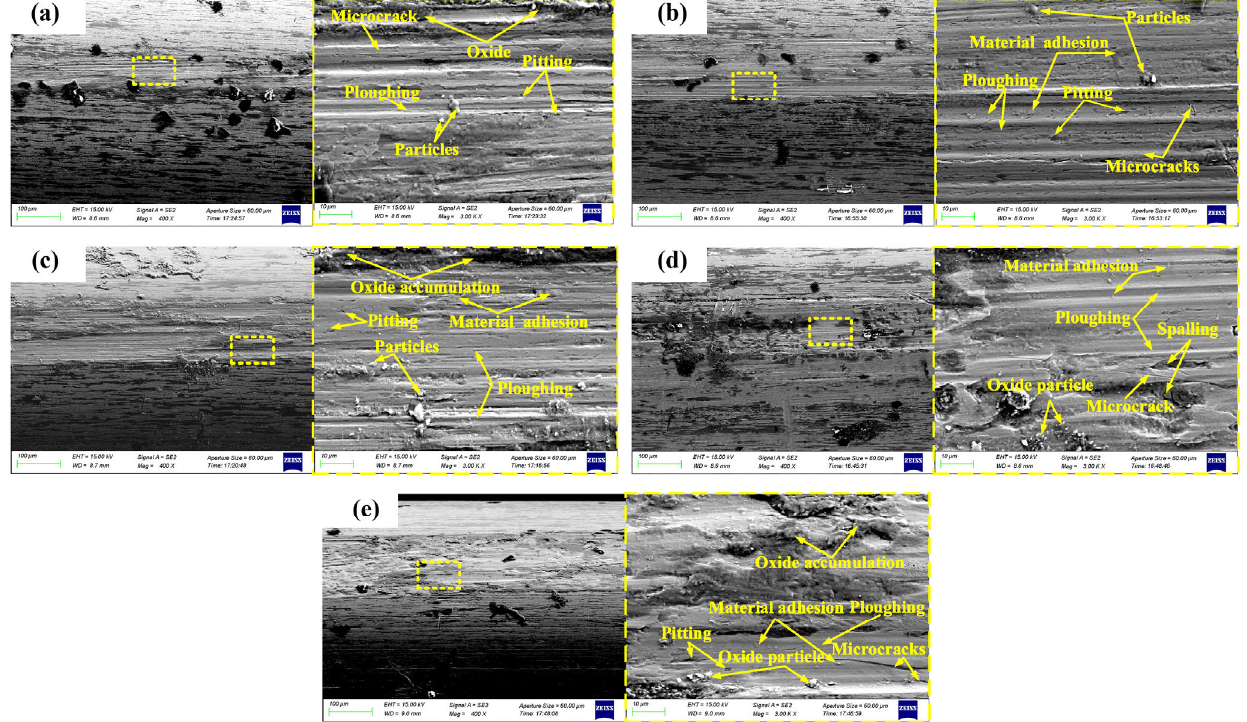
Fig. 21 Morphologies of wear scars under different tension and lateral load combinations. (a) 120 N + 80 N, (b) 120 N + 160 N, (c) 120 N + 240 N, (d) 150 N + 240 N, and (e) 180 N + 240